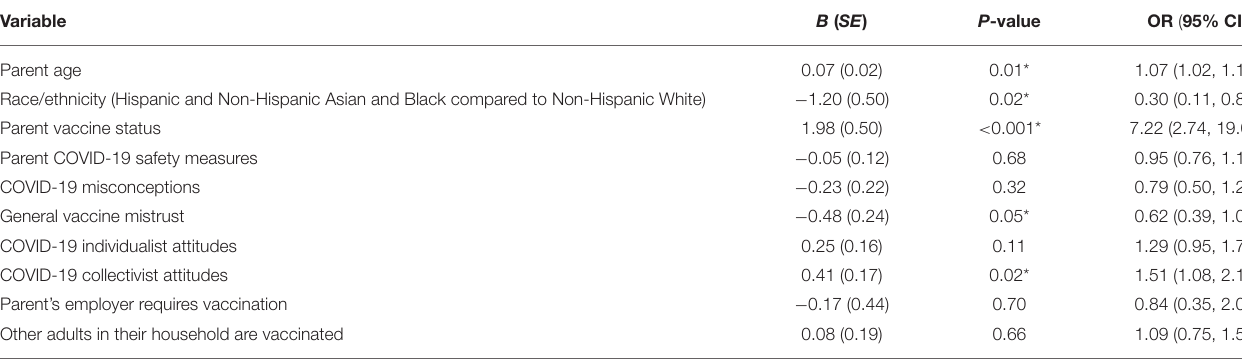
TABLE 3 | Adjusted binomial logistic regressions predicting vaccination status of adolescent child ages 12–17. Variable